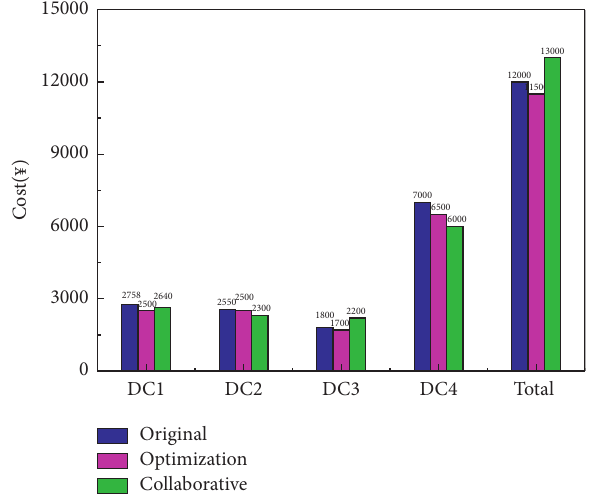
Figure 5: Cost comparison of each path optimization